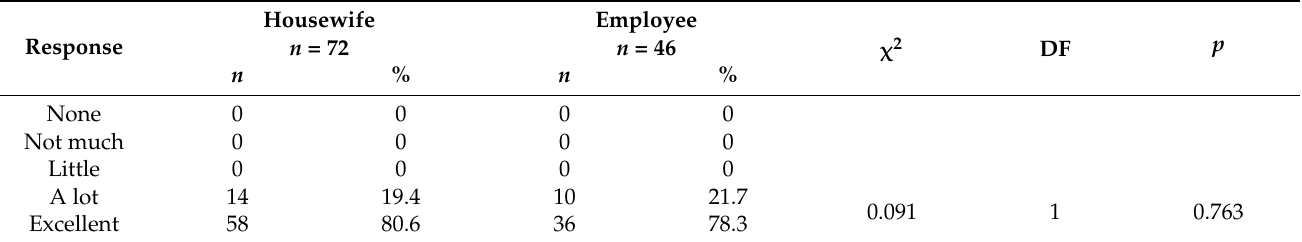
Table 7. Study results referred to the question: “How successful do you think that the orthodontists been in your treatment?” taking into consideration working